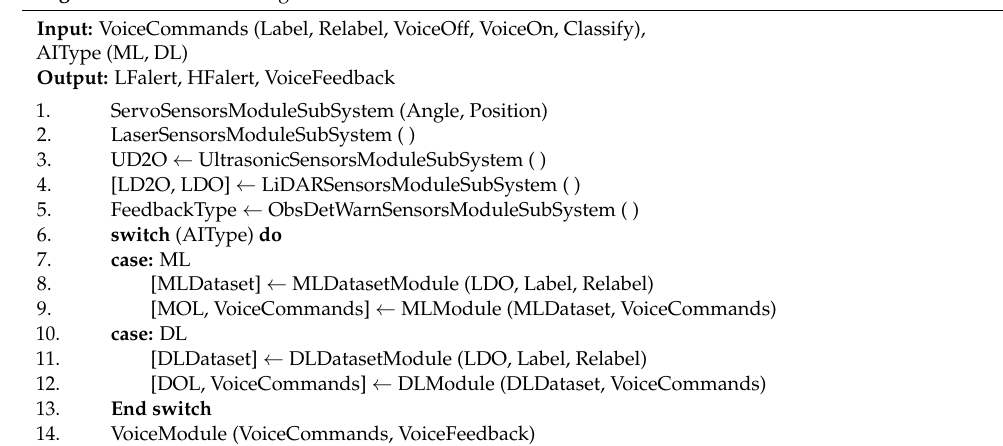
Algorithm 1: The Master algorithm: LidSonic V2.0